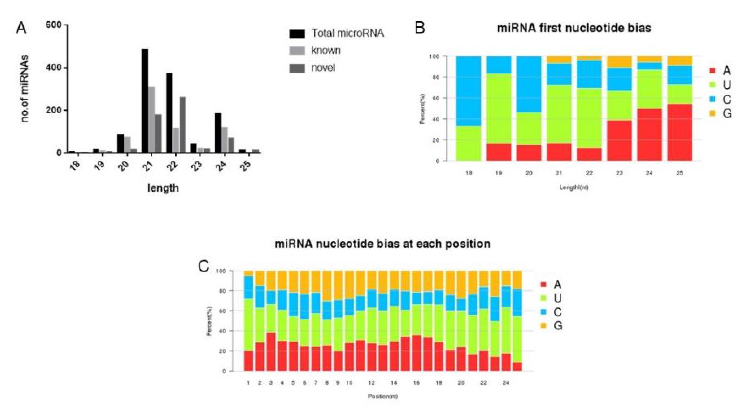
Figure 3. Characterizations of known and novel soybean miRNAs. ( A ) Size distribution of mature miRNAs, including known and novel miRNAs. ( B ) Distribution of the first nucleotide of known and novel miRNAs. ( C ) Distribution of nucleotide bias at each position of known and novel miRNAs.